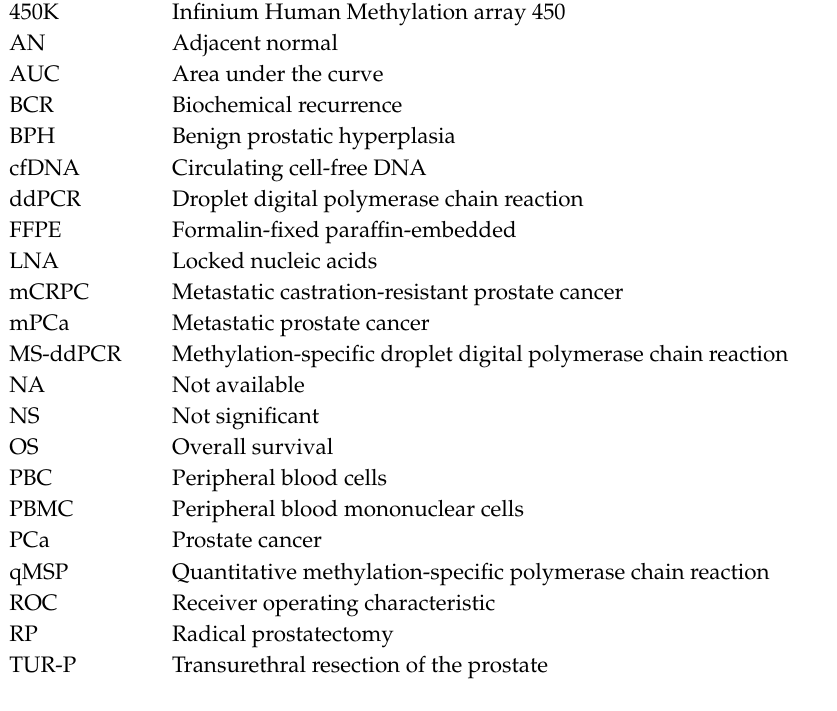
Figure S1-part1: In silico analyses of 27 biomarker candidates using the Marmal-aid database; Figure S1-part2: In silico analyses of 27 biomarker candidates using the Marmal-aid database; Figure S2-part1: Small-scale experimental validation using quantitative methylation-specific PCR (qMSP); Figure S2-part2: Small-scale experimental validation using quantitative methylation-specific PCR (qMSP); Figure S3: Association between cfDNA abundance and clinicopathological parameters in the clinical cohort; Figure S4: Kaplan–Meier survival analyses in de novo mPCa patients for DOCK2 , HAPLN3 , and FBXO30 assays individually; Table S1: Overview of samples used for small-scale experimental evaluation (qMSP), technical evaluation (MS-ddPCR), and the clinical cohort (tissue); Table S2: Overview of plasma extraction and bisulfite conversion e ffi ciency of plasma samples; Table S3: Primers and probes used for qMSP; Table S4: Reference numbers (Qiagen) for LNA primers and probes used for MS-ddPCR; Table S5: Minimum Information for Publication of Quantitative Digital PCR Experiments (dMIQE) guidelines; Table S6: Sensitivity and specificity for the 24 assays subjected to small-scale evaluation using quantitative methylation-specific PCR (qMSP); Table S7: Cox regression analyses of DOCK2 , HAPLN 3, and FBXO30 using time to mCRPC, PCa-specific survival, and overall survival as endpoints; Table S8: Sensitivity for prediction of mCRPC progression, PCa-specific survival, and overall survival for DOCK2 , HAPLN3 , FBXO30 , and ctDNA positive (by any of the three assays) vs. negative in de novo mPC